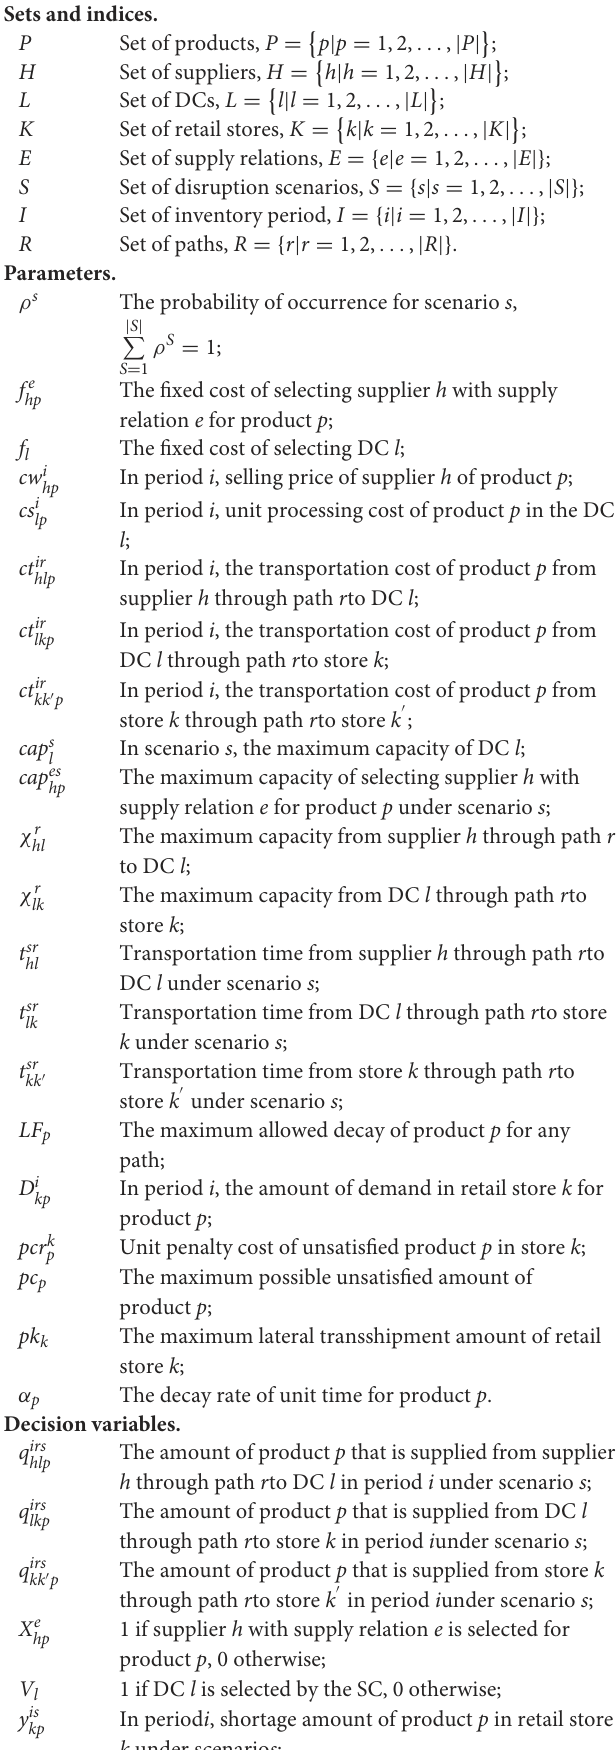
FIGURE1 The pattern of supply chain network.